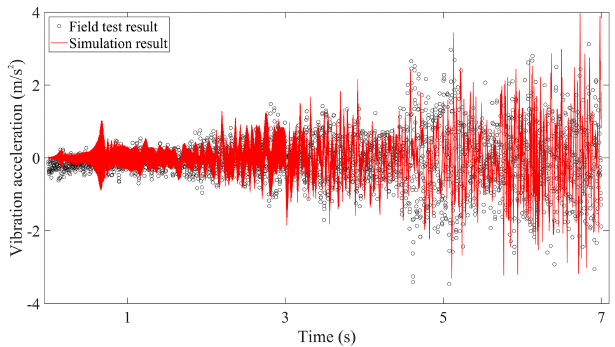
Figure 8. Comparison of vertical vibration responses of the